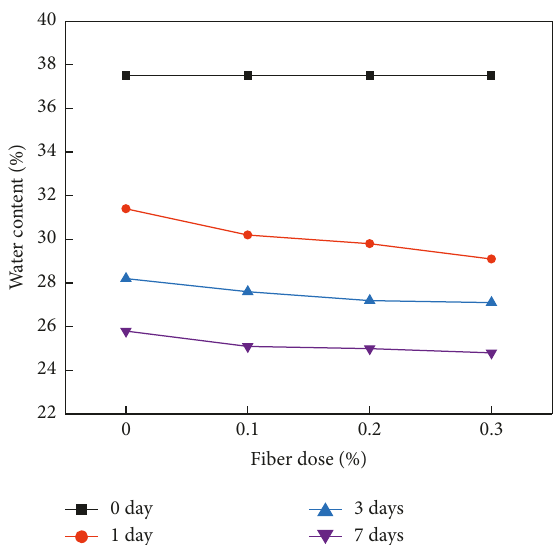
Figure 5: Diagram of the variation of cohesion of remolded soil with fiber length modulus at different conservation